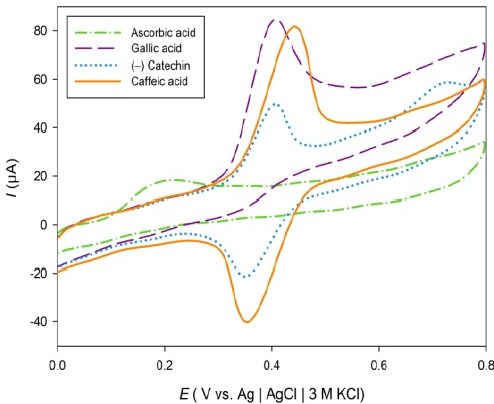
Figure 1 . Cyclic voltammograms of 40 mg L − 1 of gallic acid, ascorbic acid, ( − )catechin and caffeic acid in sodium acetate buffer solution pH 3.6 recorded at a scan rate of 100 mV s − 1 .